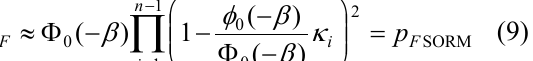
Fig. 3. The retaining wall analyzed in the